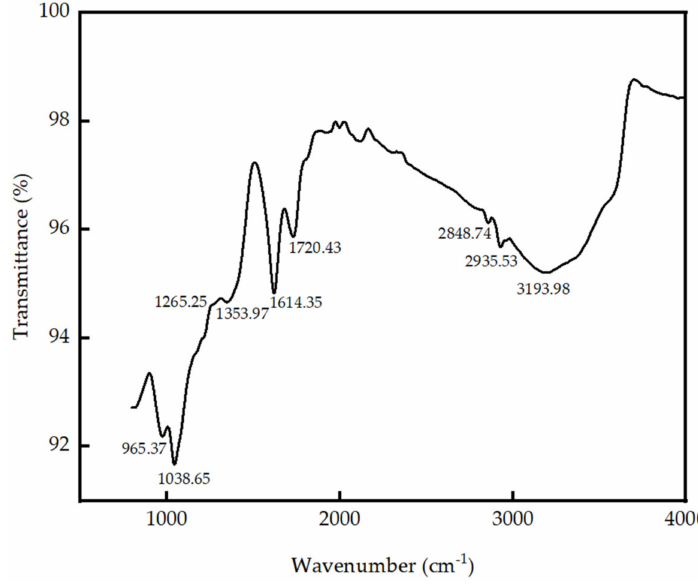
Figure 1. FT-IR of Graphene Oxide. The Raman spectrum of GO, shown in Figure 2, exhibits the G and D bands appearing at 1339.5 cm − 1 and 1584 cm − 1 , respectively, and the wide 2D band at 2696 cm − 1 . The G band is the primary mode in graphene-based material, representing bond stretching of carbon atoms in sp2 chains and rings. The existence of the D band specifies a higher degree of disorder, which arises due to gaps and defects formed in sp2 carbon rings due to oxidization heading to sp3 hybridized carbon. The 2D band originates due to the second-order Raman scattering process.